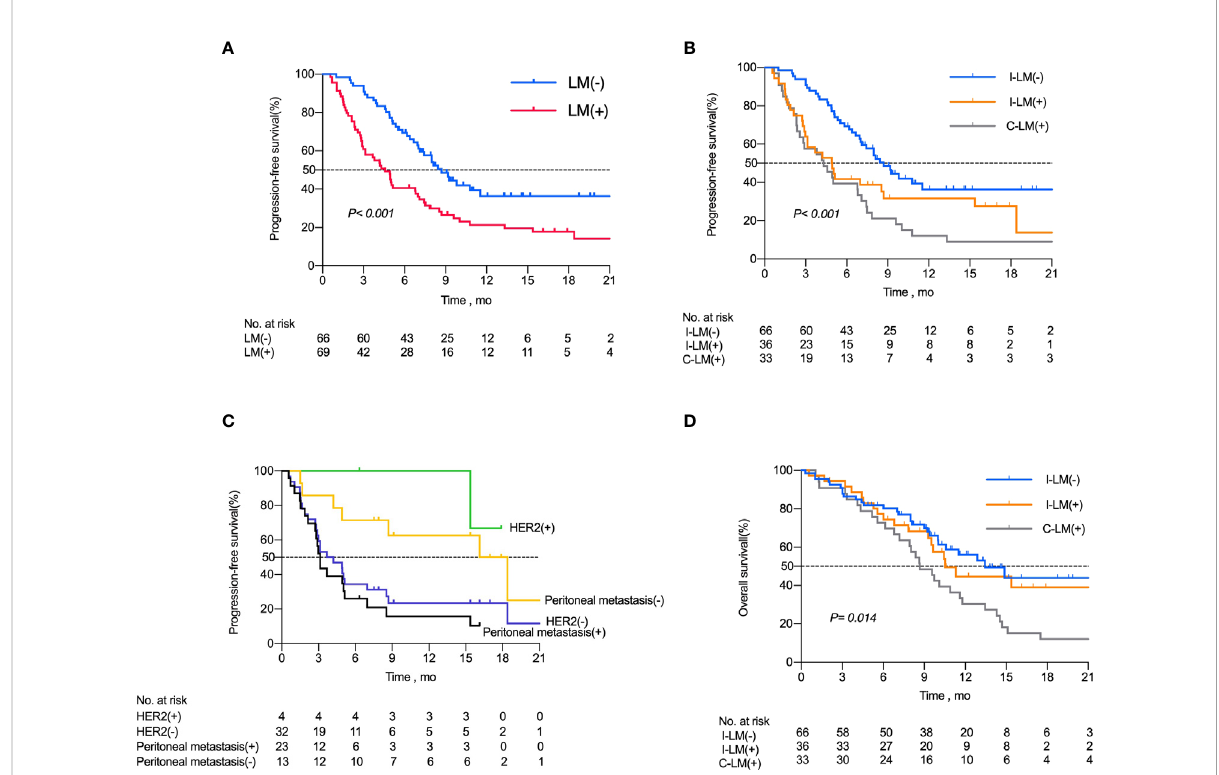
FIGURE 2 Kaplan-Meier Curves for Progression-Free Survival Among Patients with Advanced Gastric Cancer. (A) Kaplan – Meier analysis of progression free survival in all patients with or without liver metastases. (B) Kaplan – Meier analysis of progression free survival in I-LM(-) group, I-LM(+) group and C-LM(+) group, respectively. (C) Kaplan – Meier analysis of progression free survival in patients with or without peritoneal metastases in I-LM(+) group. (D) Kaplan – Meier analysis of overall survival in I-LM(-) group, I-LM(+) group and C-LM(+) group,